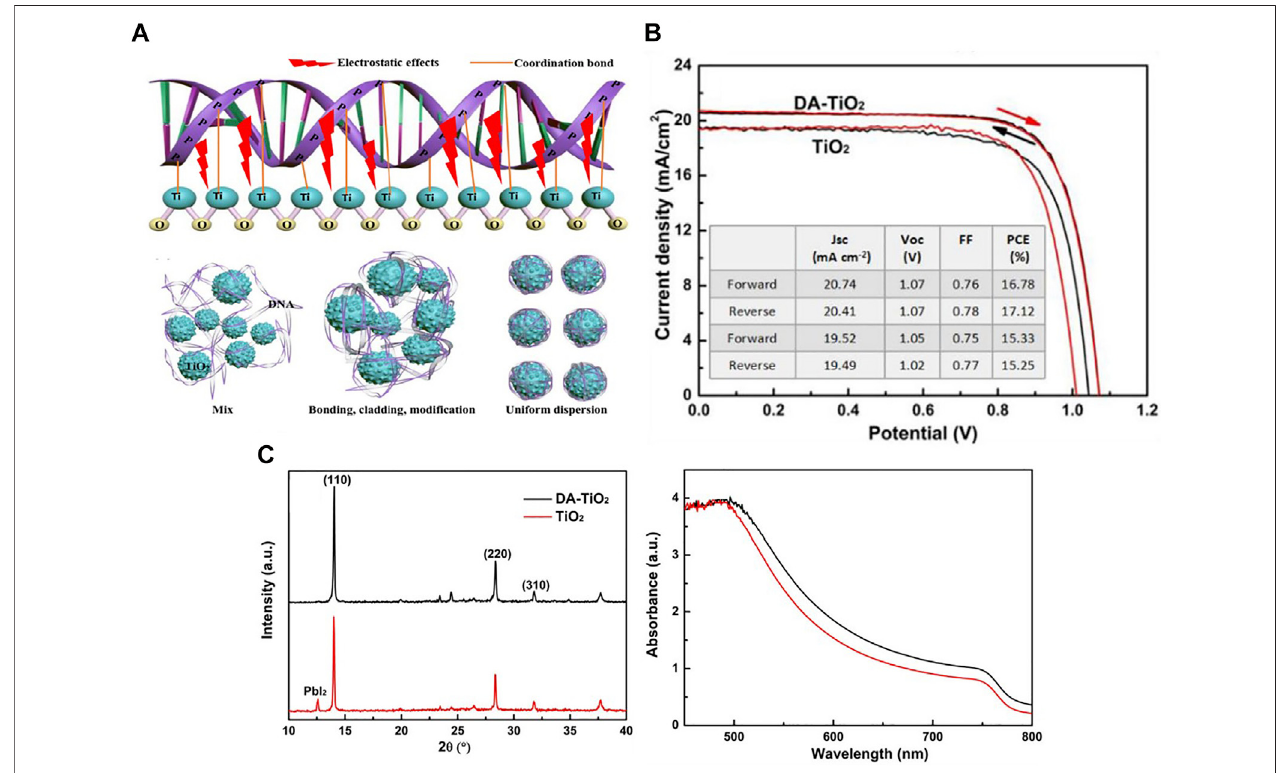
FIGURE9|(A) ThemodeldiagramoftheinteractionbetweenDNAandmeso-TiO 2 ,andtheschematicdiagramofthebindingprocessofDNAandmeso-TiO 2 . (B) Best ef fi ciency of PSCs by reverse and forward scan directions. (C) XRD patterns and UV-vis absorption spectra of perovskite fi lms deposited on dopamine (DA)-TiO 2 and TiO 2